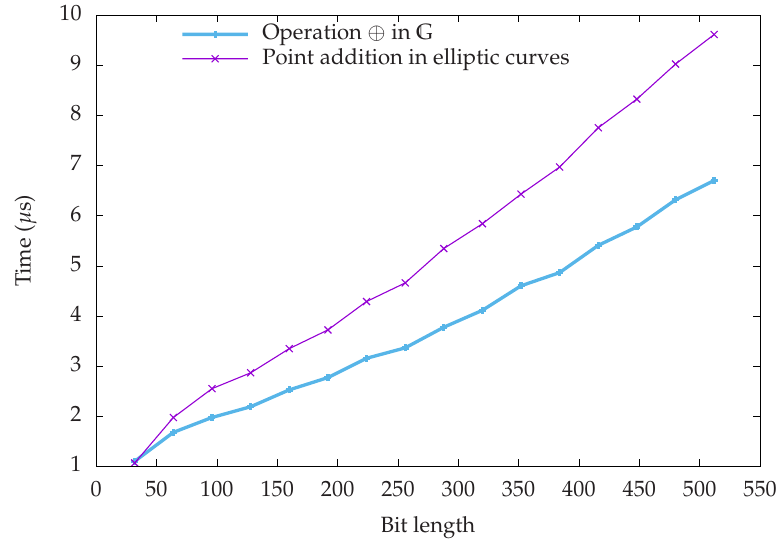
Figure 1. Comparison of average computation times for both